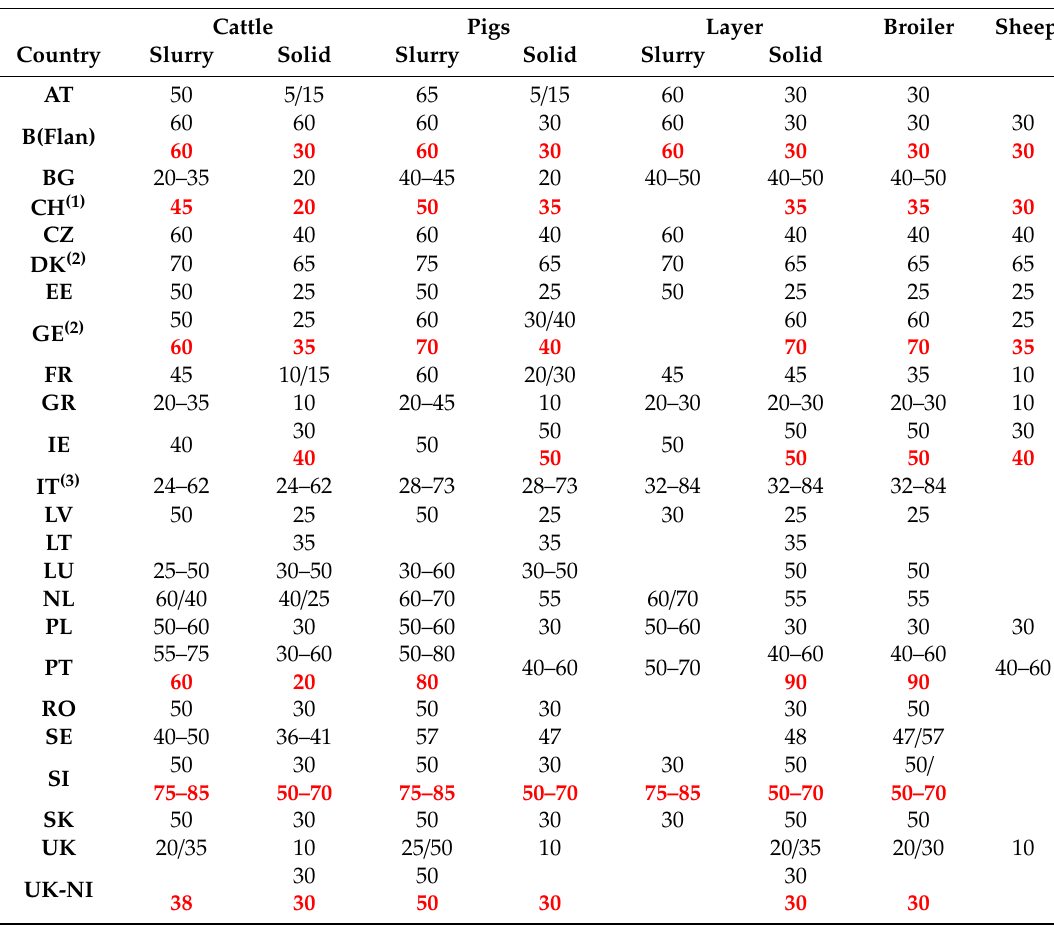
Table 3. Reported values of crop available % of total nitrogen ( = manure N e ffi ciency) [35], supplemented by data from the current survey ( red, bold figures